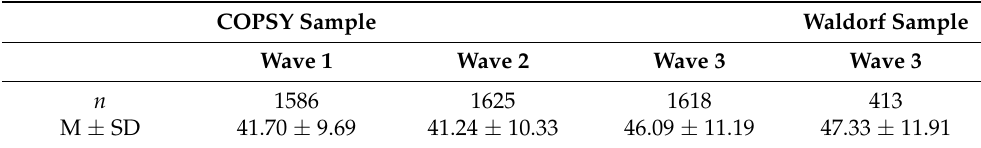
Table 4. Mean values ± standard deviations of the global HRQoL score (KIDSCREEN-10 Index, parent-proxy report) for Waldorf and COPSY